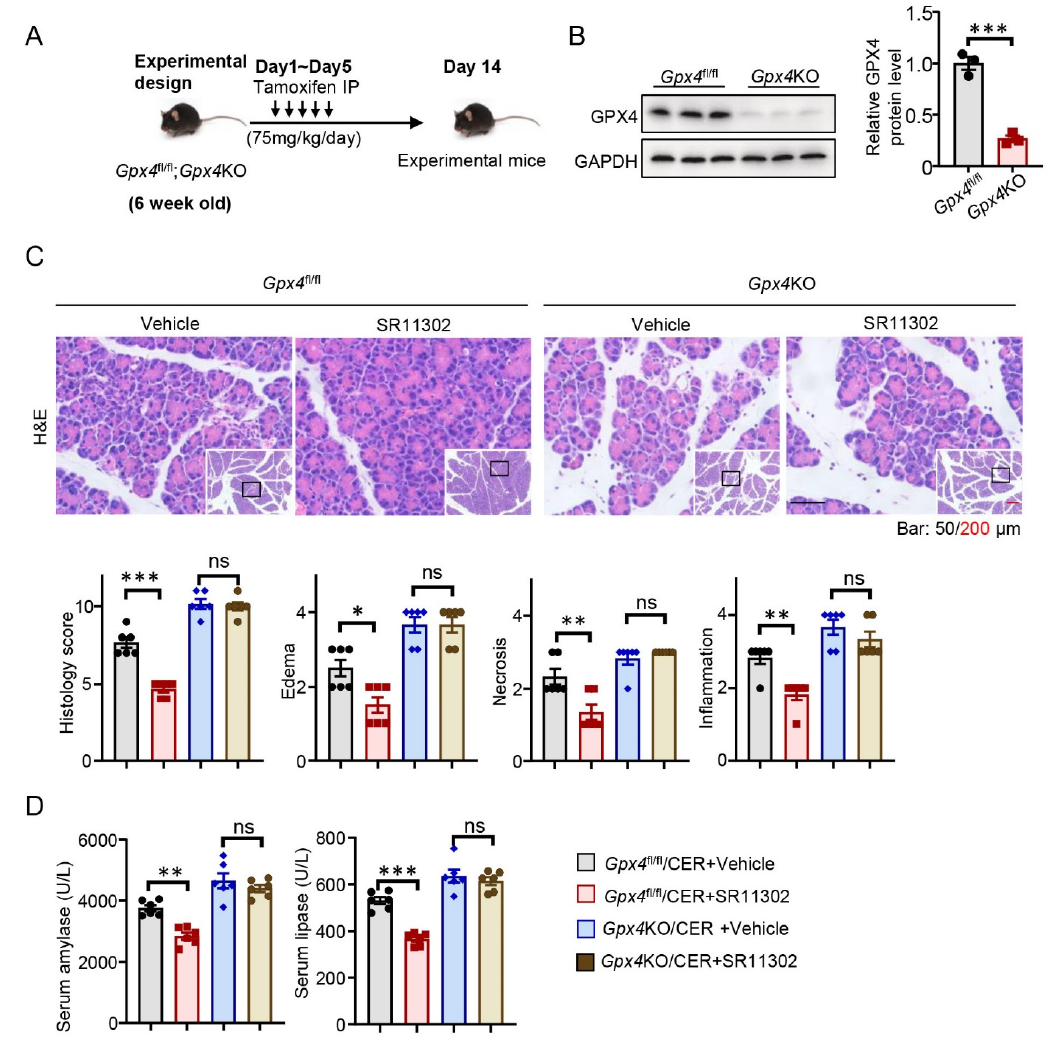
Figure 5. Glutathione peroxidase 4 ( Gpx4 ) deletion abrogates the anti-ferroptosis and anti-acute- pancreatitis effects of activating protein-1 (AP-1) inhibitor. ( A ) The experimental design of Gpx4